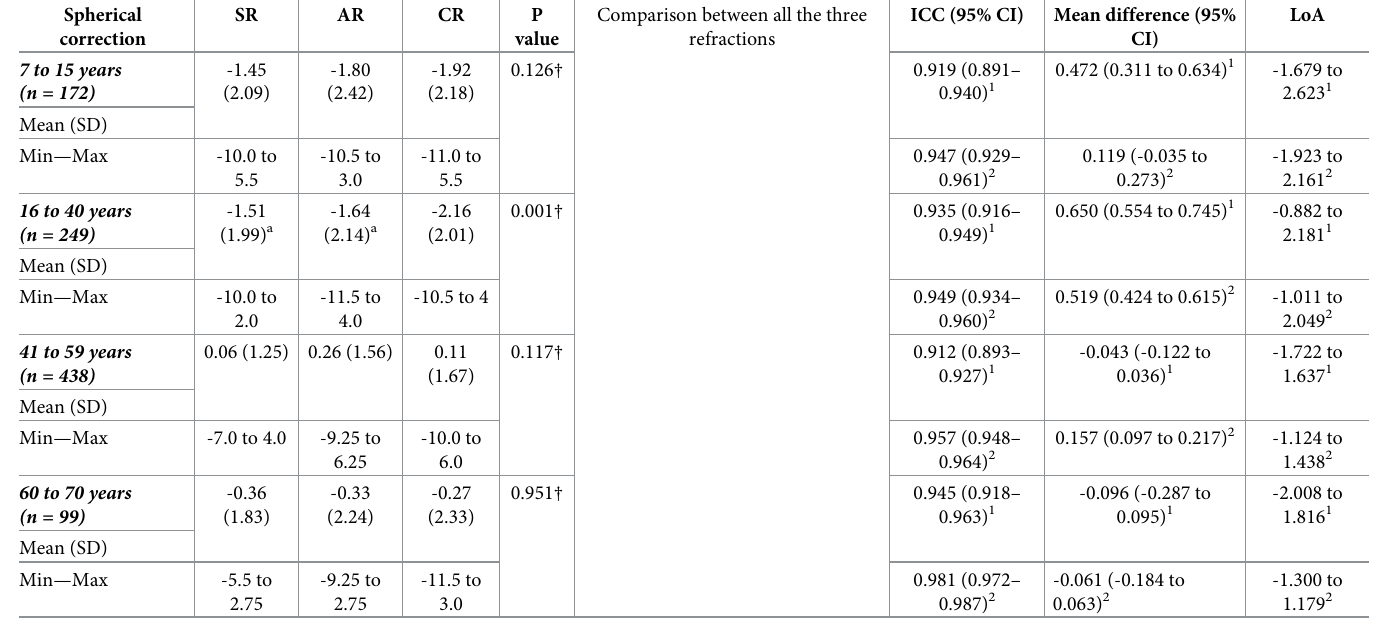
Table 2. Comparison of spherical correction estimation using SR, AR and CR across different age categories. Spherical